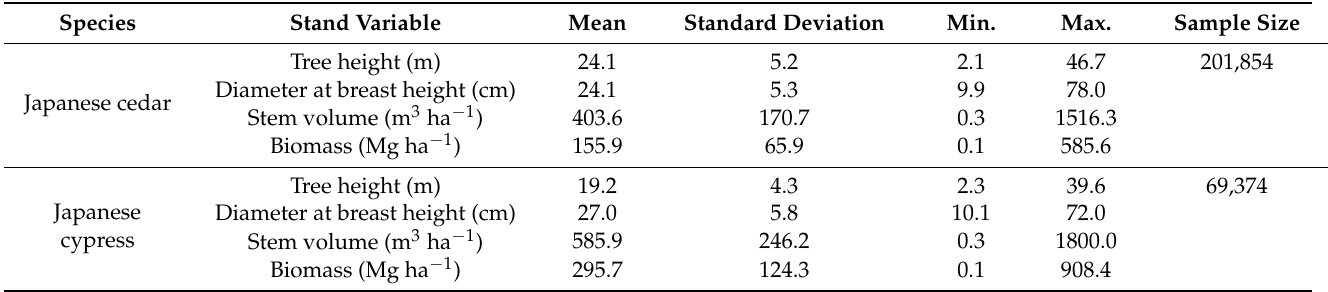
Table 1. Descriptive statistics of the forest parameters derived from airborne lidar data of Ibaraki Government.